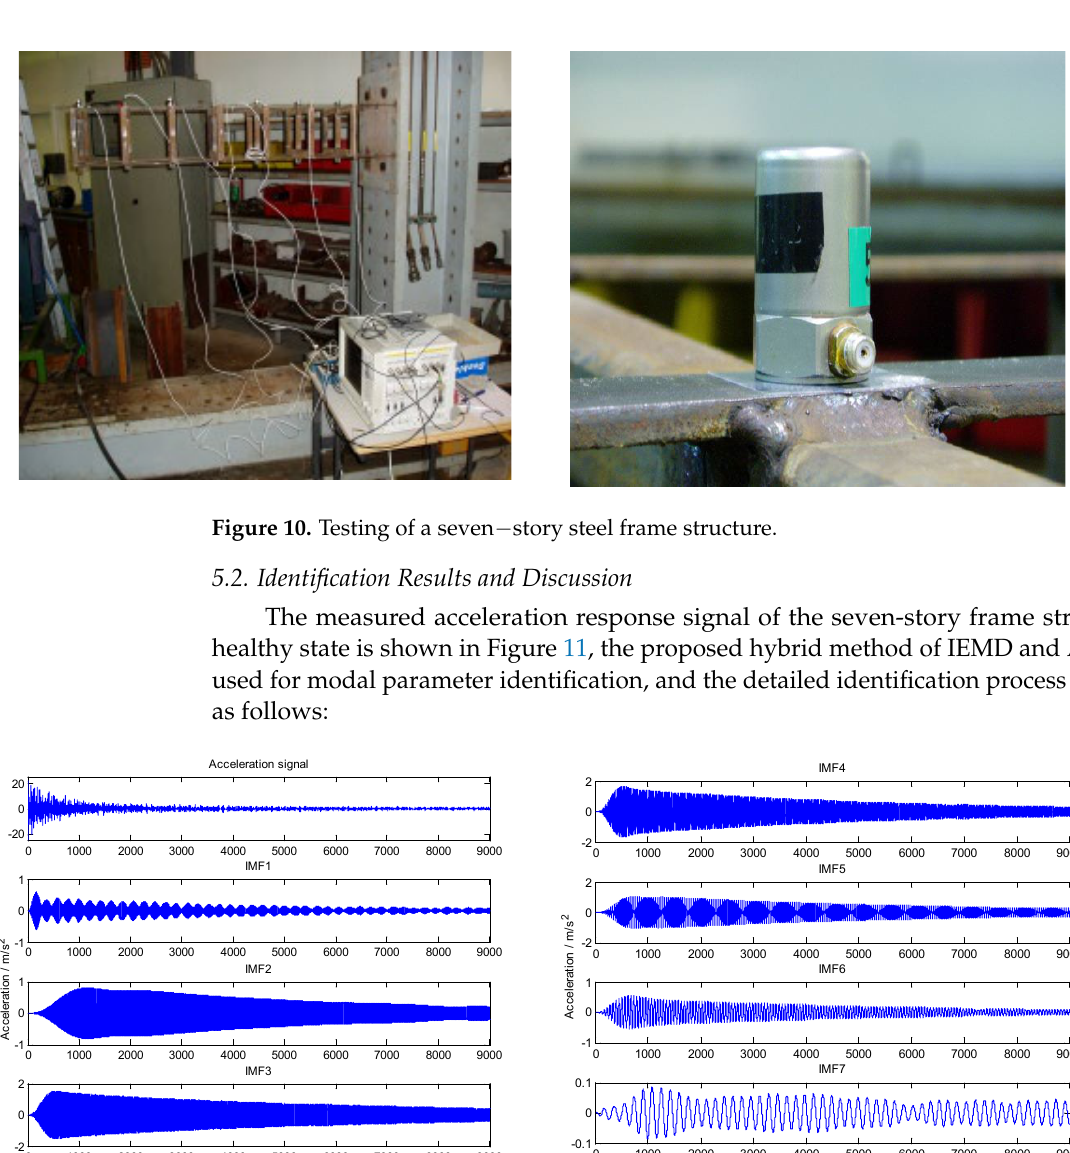
Figure 9. Seven−story steel frame model.